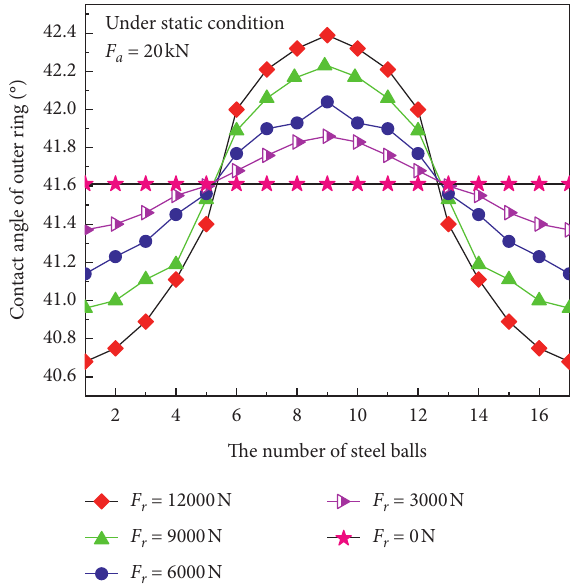
Figure 18: Change curve of actual contact angle with ball position under different axial loads.